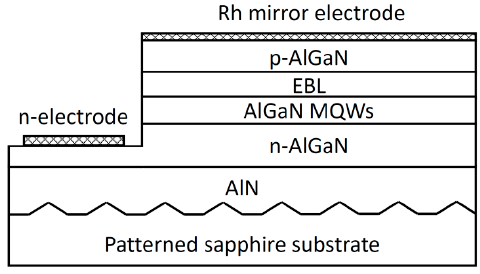
Figure 9. Schematic of UV LED structures with a transparent p-type AlGaN: Mg contact layer and a Rh mirror electrode. After Reference [8].